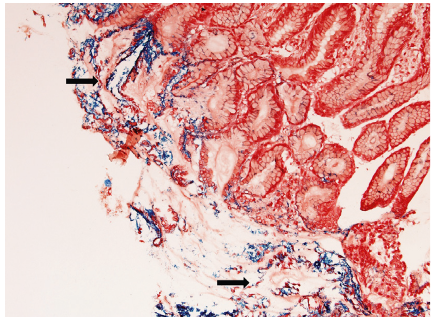
Figure 3: Special staining with PBR (black arrows) confirmed the refractile brown material to be iron